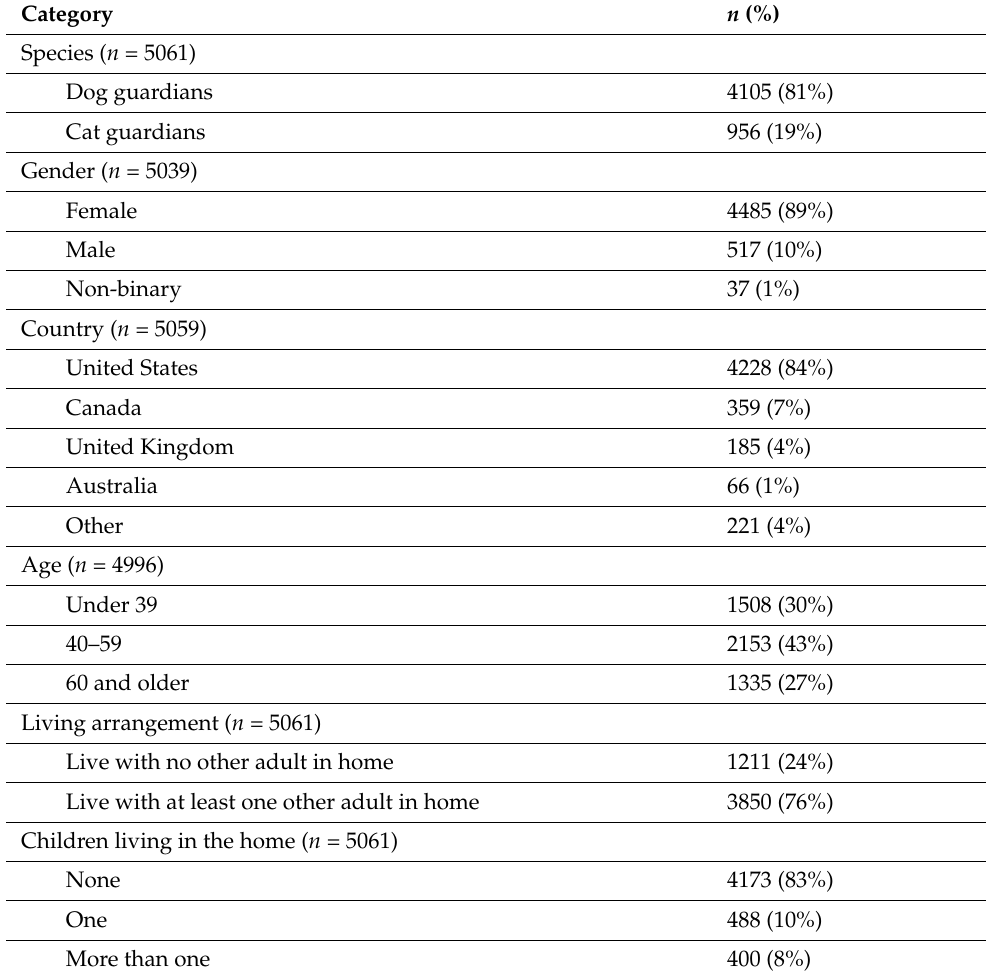
Table 1. Participant sociodemographics ( n =